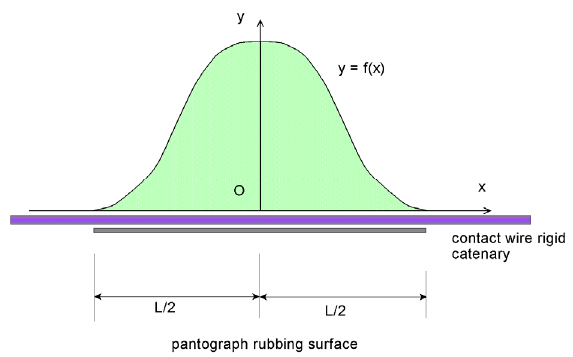
Figure 5. Law of pantograph–catenary contact distribution.